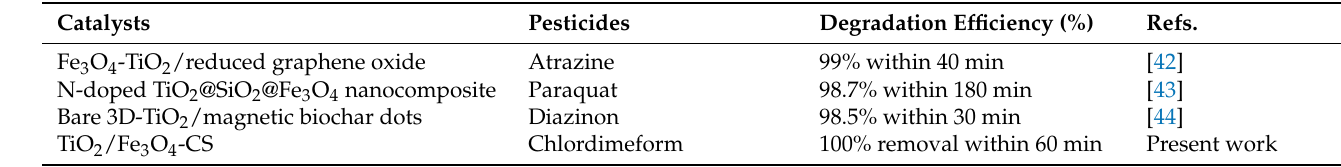
Table 2. The comparison of photodegradation efficiency of TiO 2 /Fe 3 O 4 -CS catalytic beads with other TiO 2 /Fe 3 O 4- based materials against different